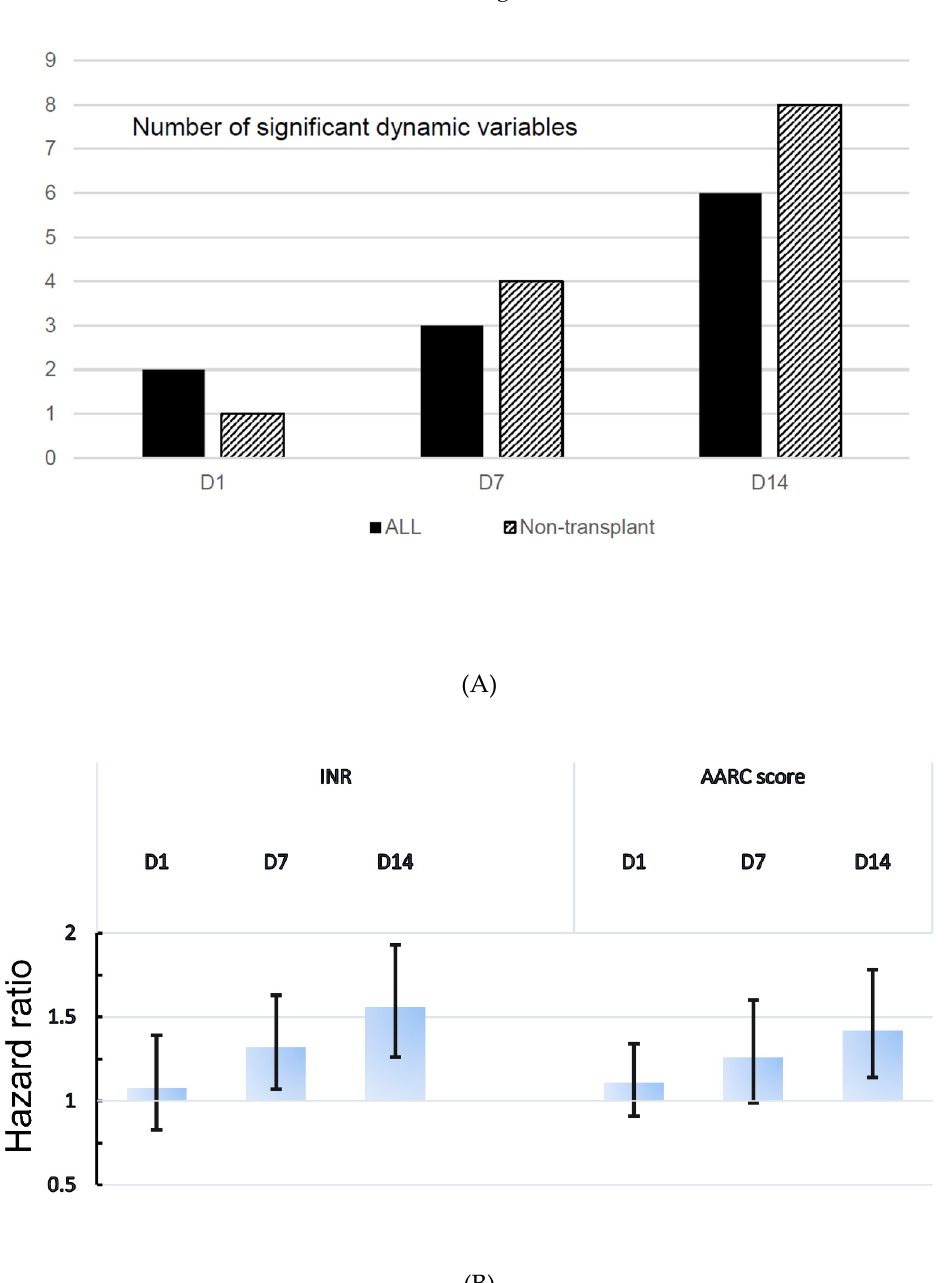
Figure 3. Dynamic prognostication. ( A ) Histogram showing the number of significant dynamic variables (at three time points (days 1, 7, and 14) after admission) associated with poorer patient survival in the nontransplant group and all patients with acute-on-chronic liver failure. ( B ) Trend of hazard ratios with 95% confidence interval for INR and AARC score at each time point. INR, international normalized ratio; AARC, APASL ACLF Research Consortium (ACLF, acute-on-chronic liver failure, APASL, the Asian Pacific Association for the Study of the Liver).